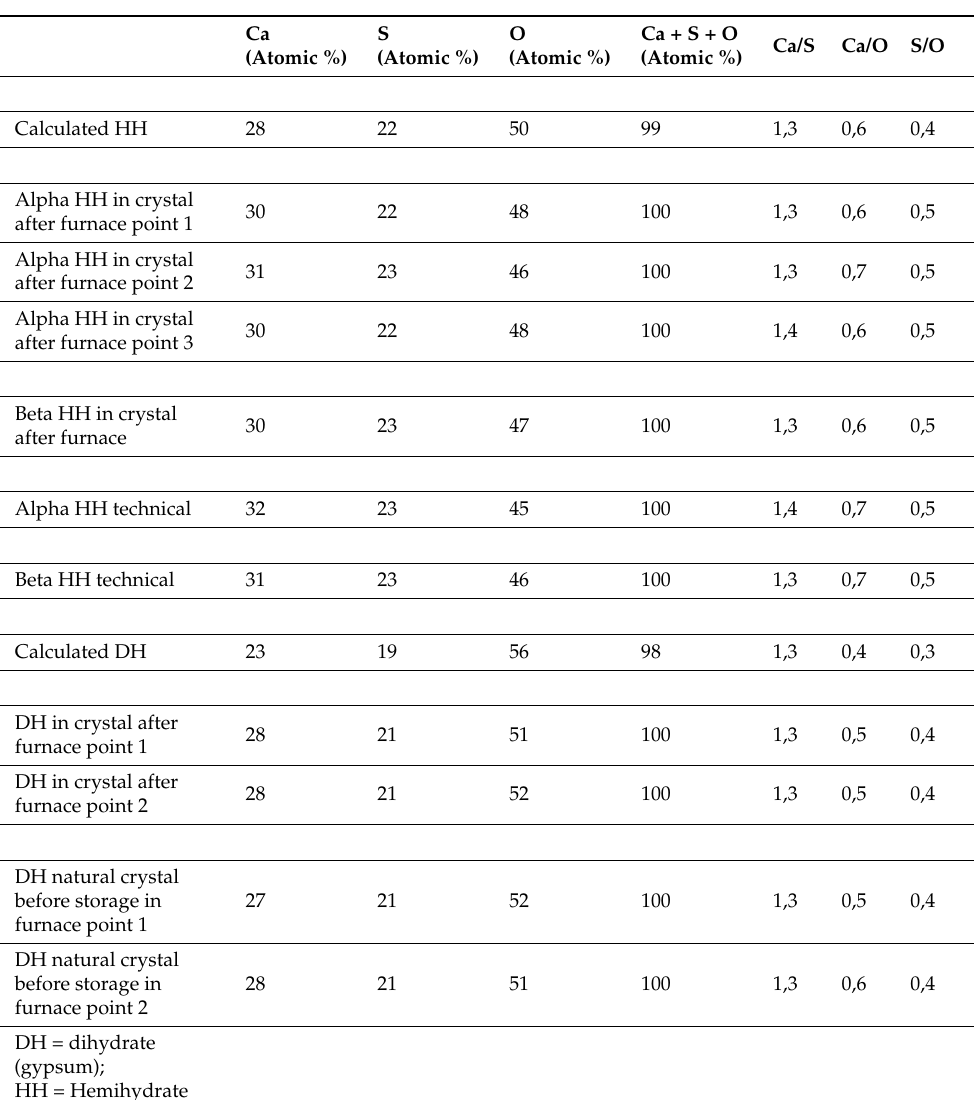
Table 1. EDX results of crystal after 140 ◦ C